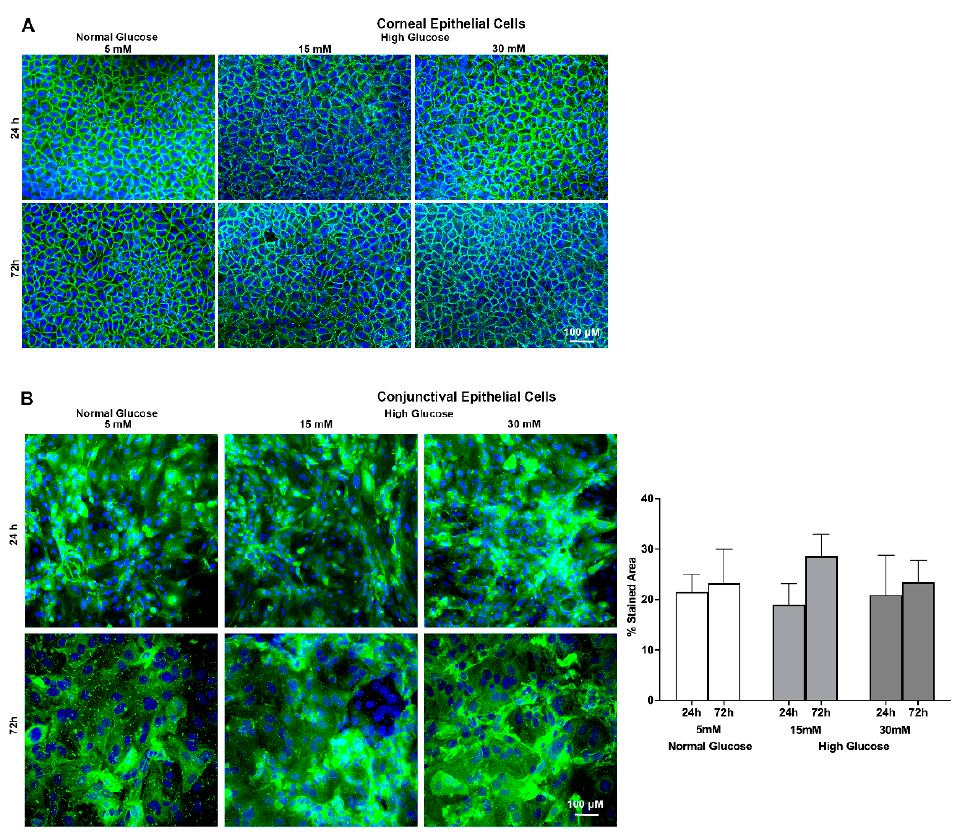
Figure 4. ( A ) Representative confocal microscopy images showing effect of a high glucose level (15 mM; 30 mM) on O-glycosylated Gal β 1-3GalNAc oligosaccharide side chains of membrane-tethered mucins on stratified human corneal epithelial cells. ( B ) Representative confocal microscopy images showing effect of a high glucose level (15 mM; 30 mM) on O-glycosylated Gal β 1-3GalNAc oligosac- charide side chains of membrane-tethered mucins on stratified human conjunctival epithelial cells. Nuclei are stained blue with DAPI, and O-glycosylated linked oligosaccharides are stained green with jacalin. Graphs show the percent-stained area as quantified using Image J software of n = 6 images/group. The images were obtained from cell culture experiments conducted in triplicate. Scale bar = 100 μ M.